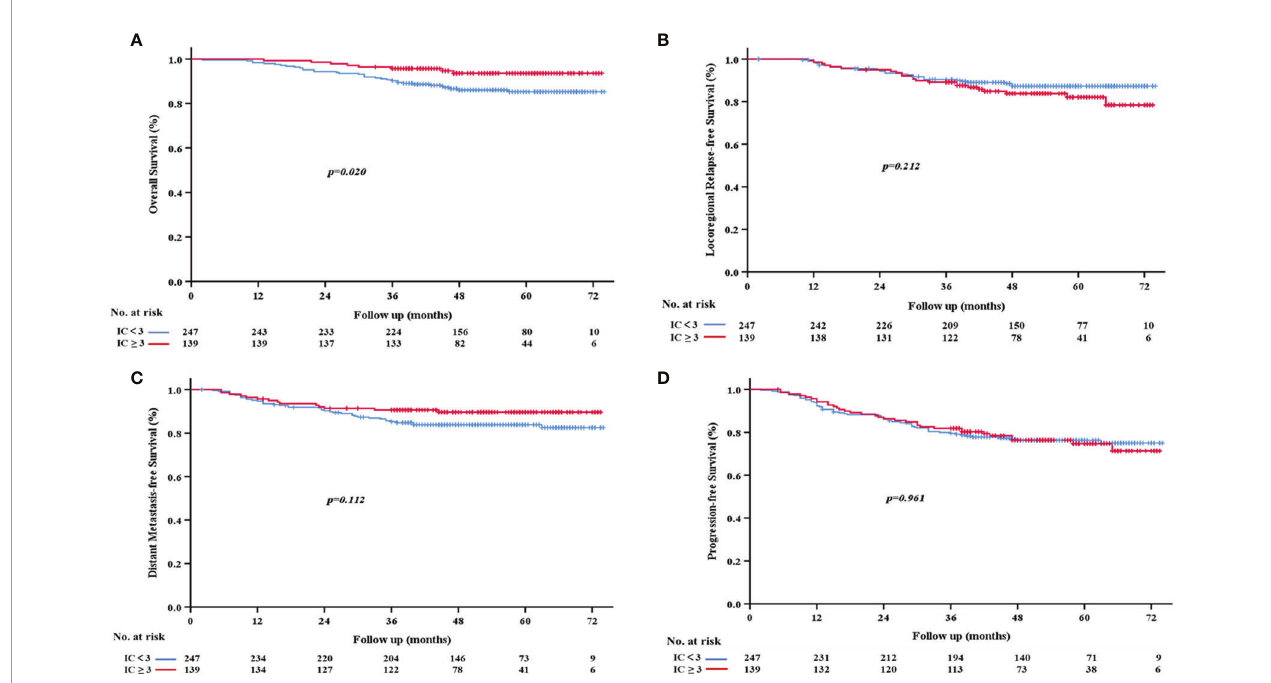
FIGURE 3 | Kaplan-Meier survival curves based on the number of cycles of induction chemotherapy. (A) Overall survival; (B) locoregional relapse-free survival; (C) distant metastasis-free survival; (D) progression-free survival. TABLE 2 | Univariate Cox regression analysis for all patients.